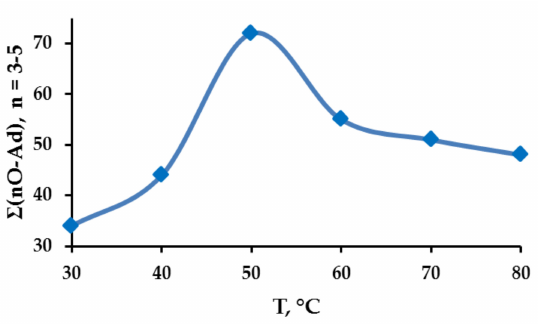
Figure 7. The dependence of the sum of products Σ (nO-Ad), n = 3–5, on T. If the envelopes of the wide peaks on the chromatogram of 50 ◦ C are taken as the component of the wide peaks on the chromatogram of 70 ◦ C (Figure 4), then at 50 ◦ C, the content of the narrow peaks 1a , 2a , 3a , 4a , and 5a is 5, 4, 10, 3 and 0%, respectively, the total content of these tertiary alcohols is 22% (Figure 4). Thus, at 50 ◦ C, the highest yield of 3a (10%) is